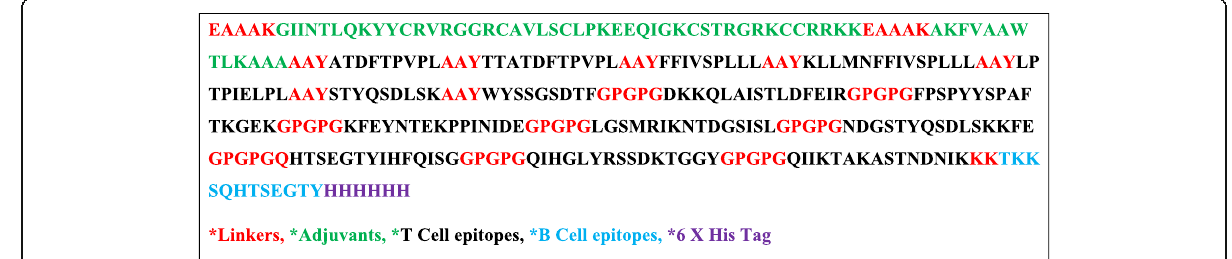
Fig. 2 Multi-epitope vaccine constructed by mapping both B cell and T cell epitopes with linkers and